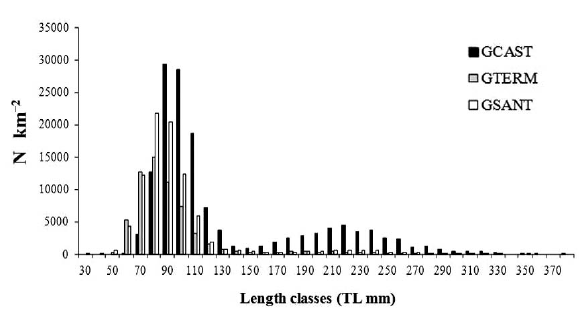
Fig. 2. – Length-frequency distribution (N km –2 ) of hake in the three gulfs. GCAST, Gulf of Castellammare; GTERM, Gulf of Termini Imerese; GSANT, Gulf of Sant’Agata